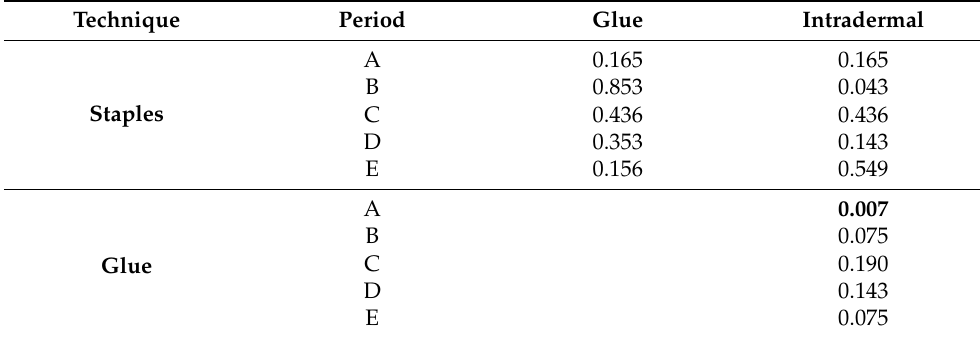
Table 4. p values of comparisons between techniques for total